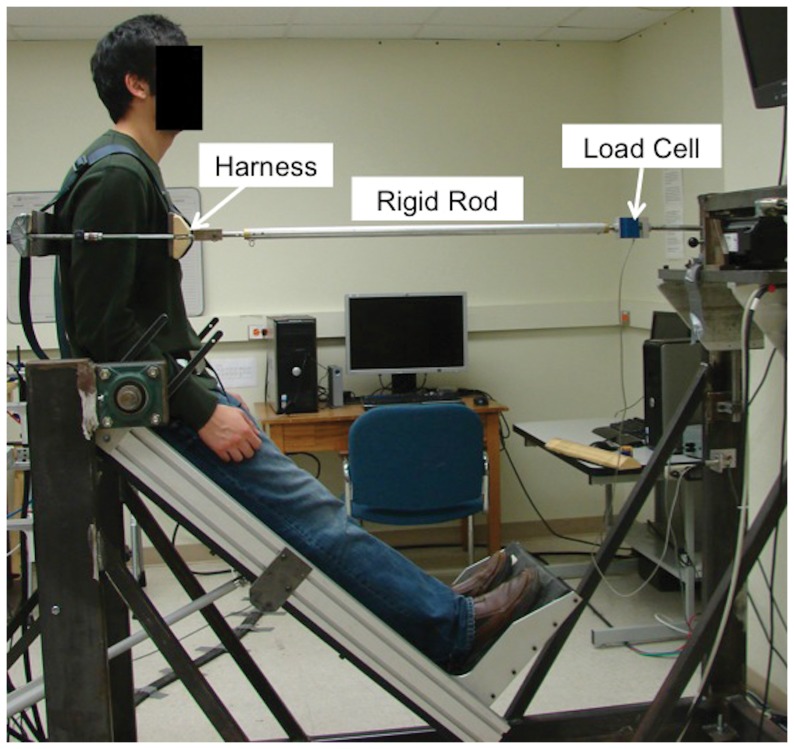
Experimental setup for load-relaxation test (60% FR angle condition illustrated).